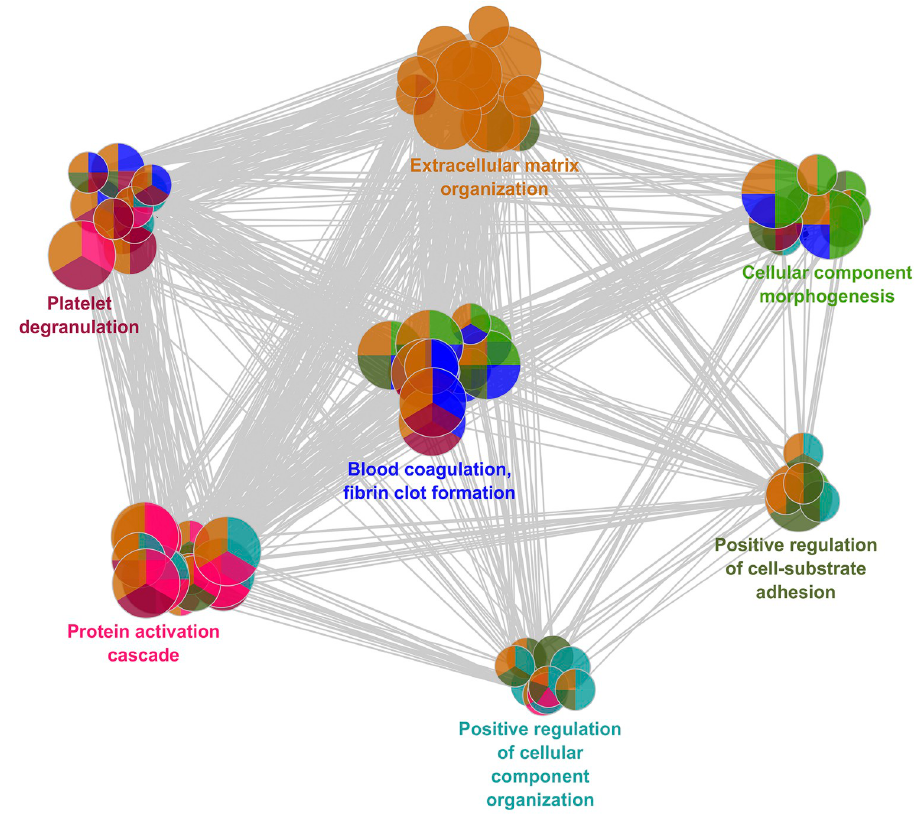
Fig 3. Grouping of networks based on functionally enriched GO terms. The functionally grouped network of enriched categories was generated for the differential proteins using ClueGO. GO terms are represented as nodes, the edges connecting the nodes are based on the kappa statistic that measures the overlap of shared genes between terms (less to 0.4). The node size indicates the number of proteins mapped to each term and the color represents the term enrichment significance. Only the most significant term in the group is labeled. Functionally related groups partially overlap. Visualization has been carried out using Cytoscape